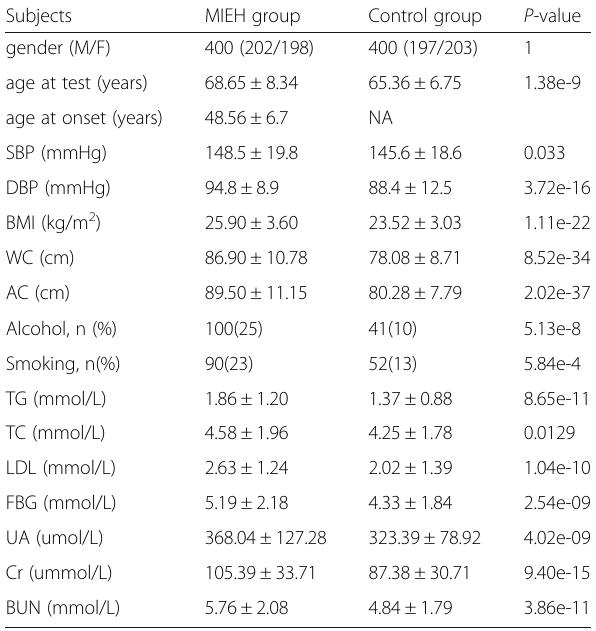
Table 1 Comparison of baseline clinical data between the MIEH and control